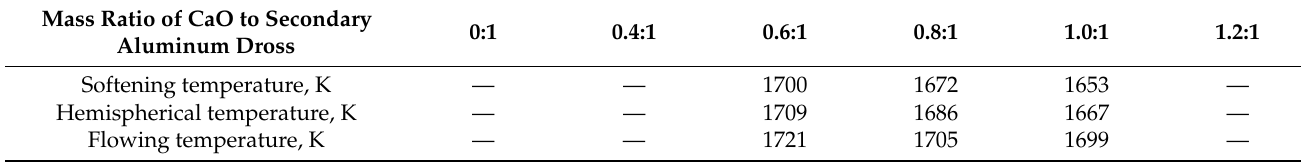
Table 3. Melting point of raw material mixture measured by the